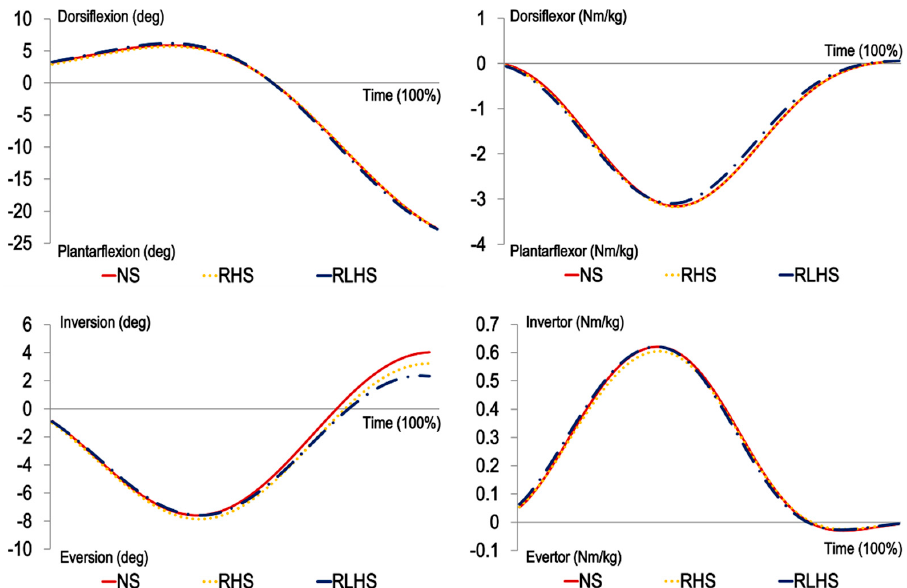
Figure A1. Comparison of ankle joint angles and moments between the shoes.